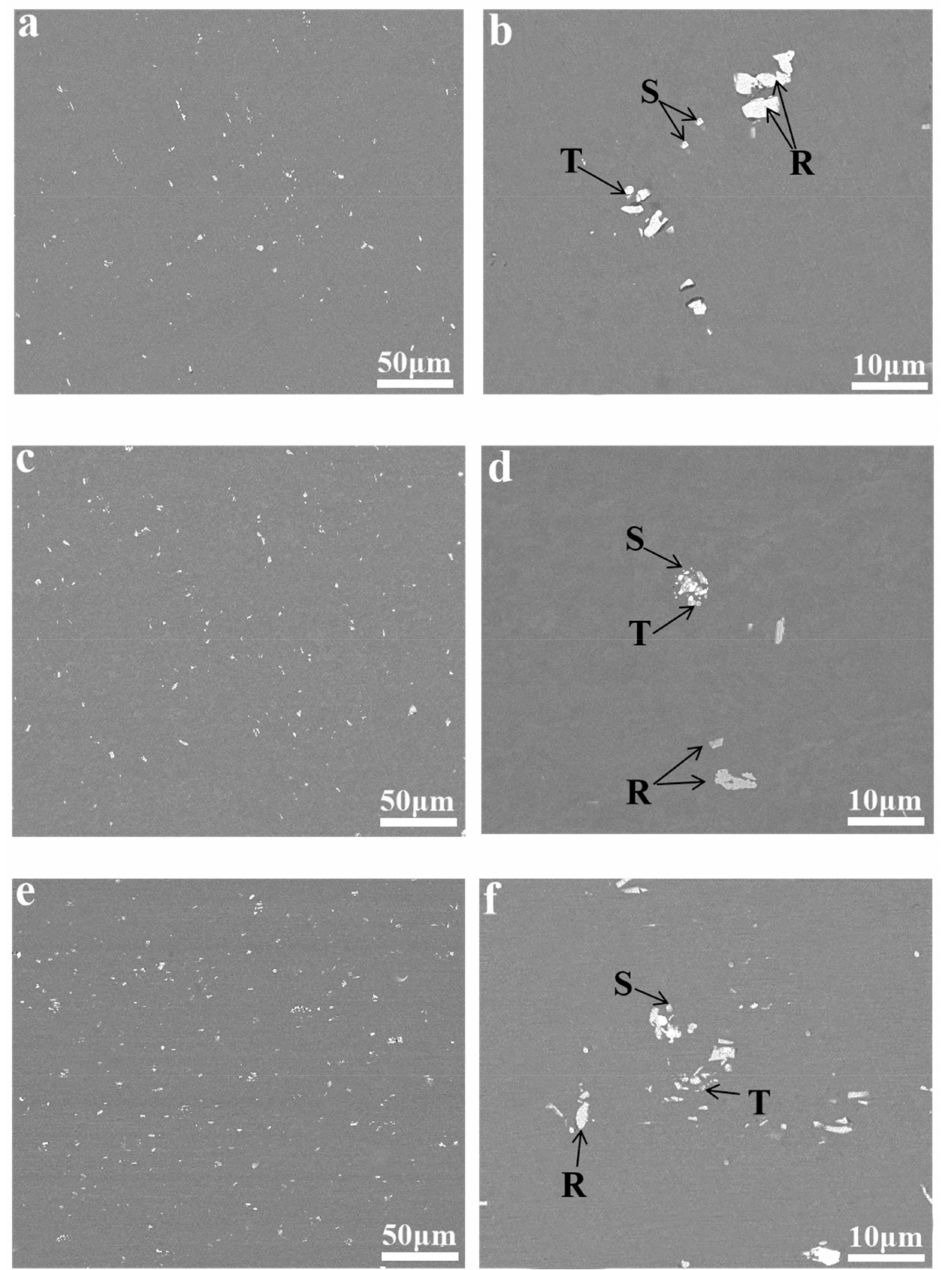
Figure 1. Microstructure of the Al–xFe–0.1Si–0.07La alloy foils: ( a ) and ( b ) Al–0.07Fe–0.1Si–0.07La; ( c ) and ( d ) Al–0.2Fe–0.1Si–0.07La; and ( e ) and ( f )